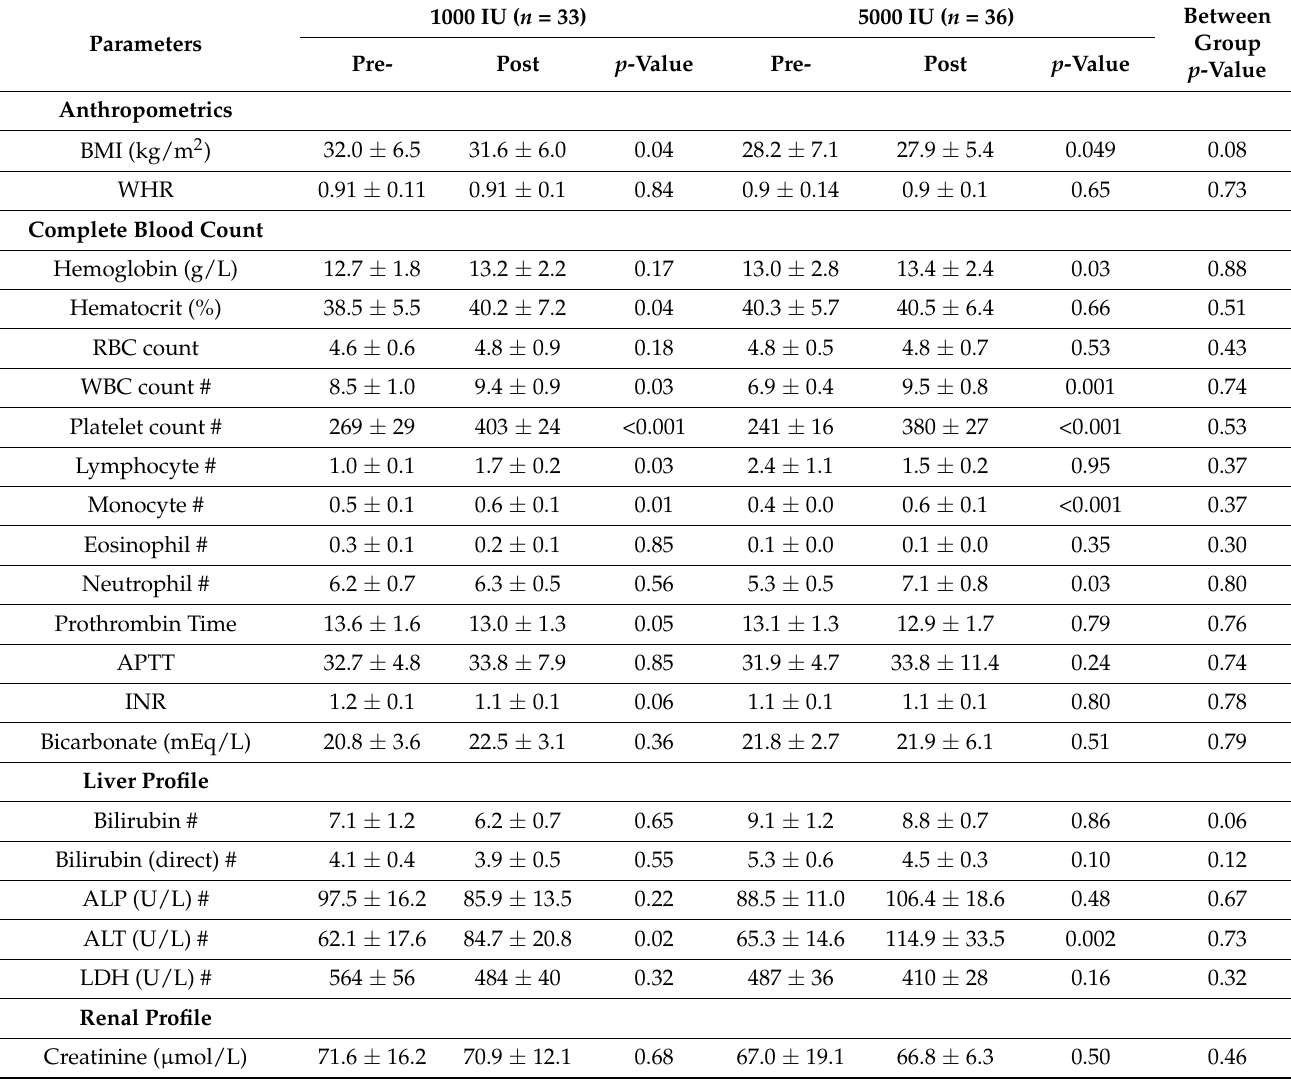
Table 3. Pre and Post Clinical parameters according to Vitamin D